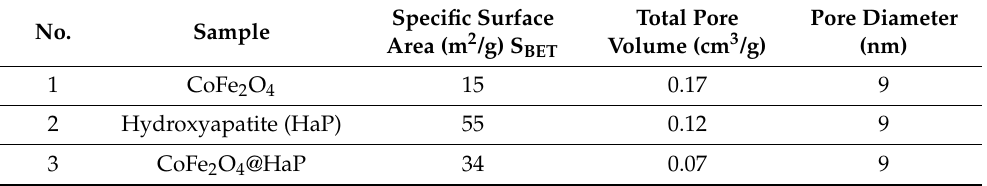
Figure 7. Adsorption-desorption isotherms (CoFe 2 O 4 — a ( 1 ), Hydroxyapatite (HaP)— b ( 1 ), CoFe 2 O 4 @HaP— c(1) ), pore distributions after adsorption-desorption isotherms ( a ( 2 ), b ( 2 ), c ( 2 )) . Table 4. Textural properties of the synthesized